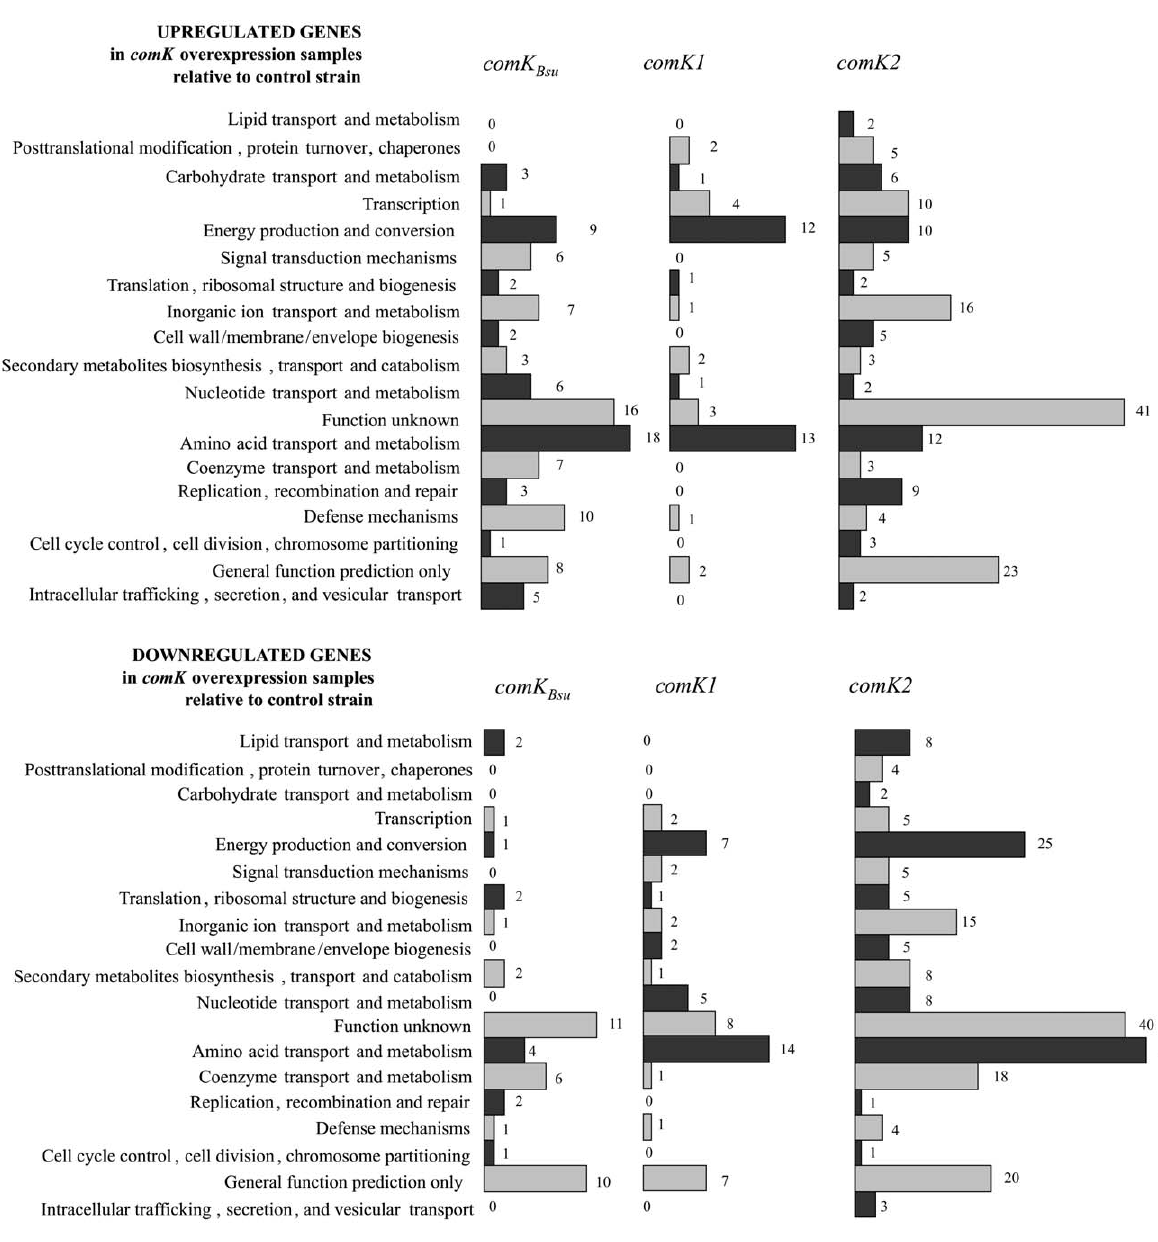
Figure 1. Numbers of genes belonging to the clusters containing commonly up- (above) or downregulated (bellow) genes upon comK overexpression classified using COG functional